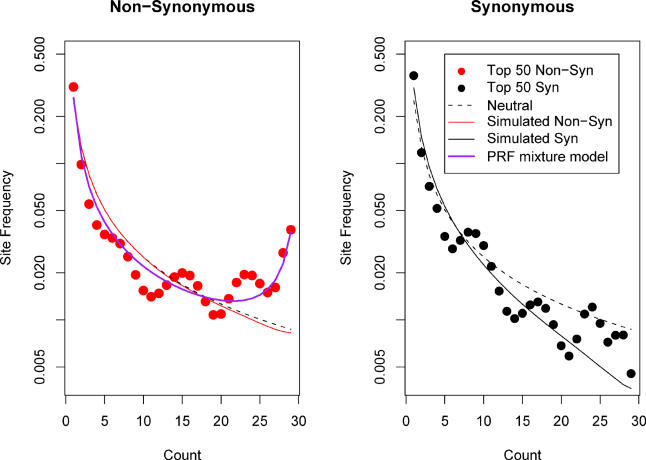
Frequency SpectraThe figure shows the frequency spectra of nonsynonymous (red) and synonymous (black) mutations among the 50 genes showing the strongest evidence for positive selection in the interspecific comparison. Also shown is the expectation from the standard neutral model, expectations from the neutral model taking the protocol used to select the 50 genes into account (see text), and from the prediction of the selection model. On the x-axis is the number of derived allele in a sample of size 30 chromosomes (Count), and on the y-axis is the proportion of sites expected in the sample with a particular frequency.